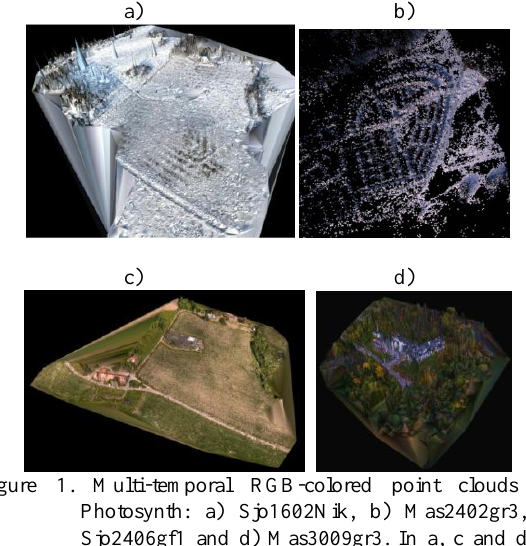
Figure 1. Multi-temporal RGB-colored point clouds by Photosynth: a) Sjo1602Nik, b) Mas2402gr3, c) Sjo2406gf1 and d) Mas3009gr3. In a, c and d an interpolated point cloud is shown (indicated sufficiently dense and inclusive point cloud) but in Sundsberg data the interpolation was not successful. RGB colored point clouds created by Photosynth using winter, summer and autumn images are shown in Figure 1. Photosynth was succesful in ordering all tested blocks and provide point clouds without any apriori orientation information. Lower point densities were experienced in uniform surfaces (asphalt, flat roof covers, snow) and some noise appeared in point clouds (not visible in Figure 1). Point cloud quality was in average poorer in snow covered areas, but as far there were some features, processing was